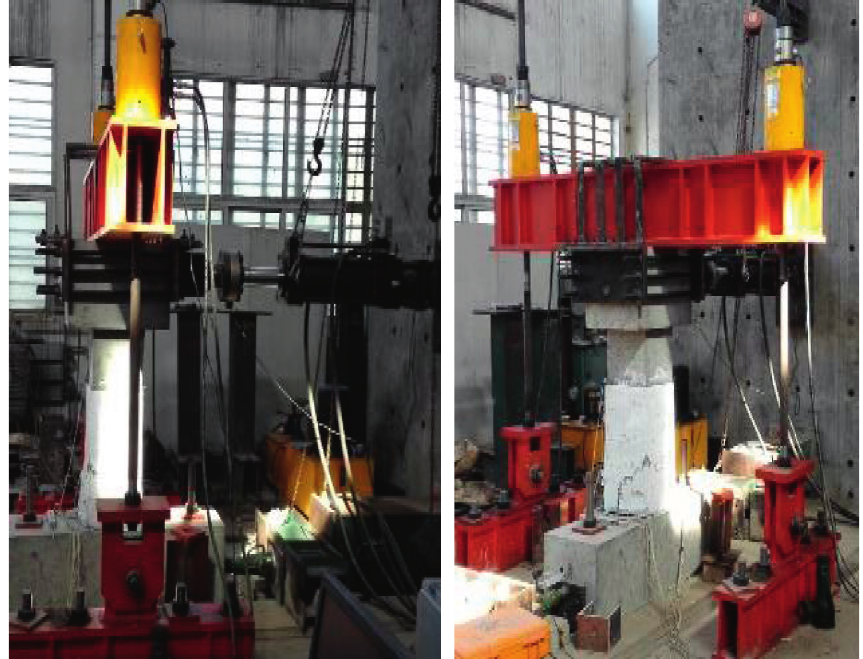
Figure 3: Test loading